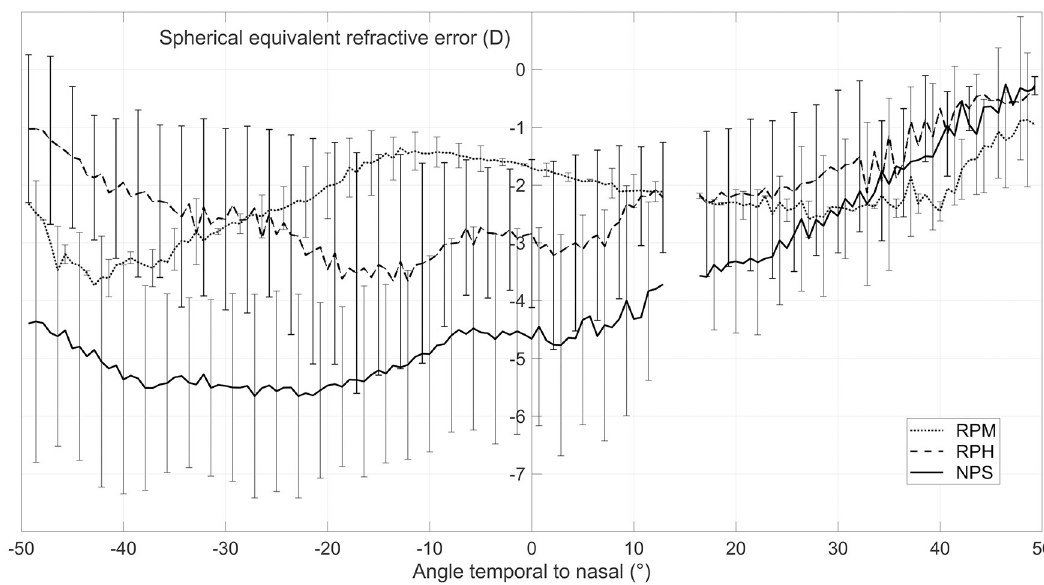
Fig 2. Uncorrected peripheral refraction. The average uncorrected eccentric refraction profiles are divided into three groups: NPS, RPH and RPM. Visualization clearly shows the distinct behavior of the peripheral refractive error compared to the central refractive error of the different groups. Error bars indicate the standard deviation and are plotted only for every third angle of measurement for reasons of clarity.